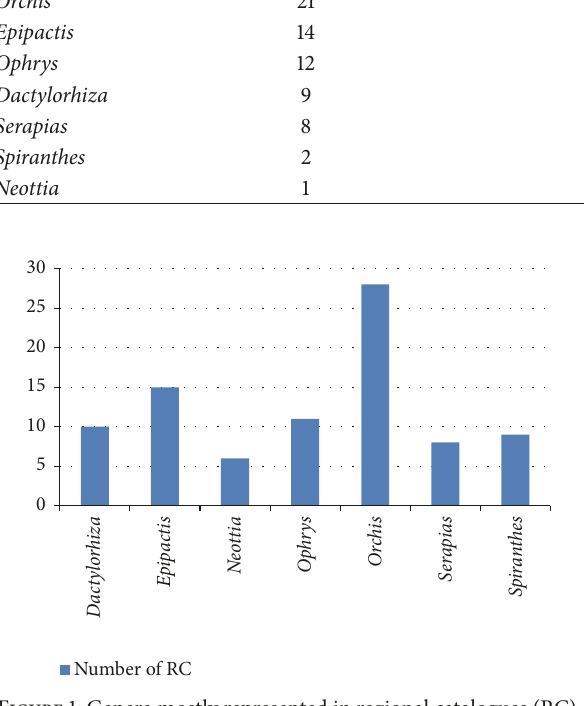
Figure 1: Genera mostly represented in regional catalogues (RC).